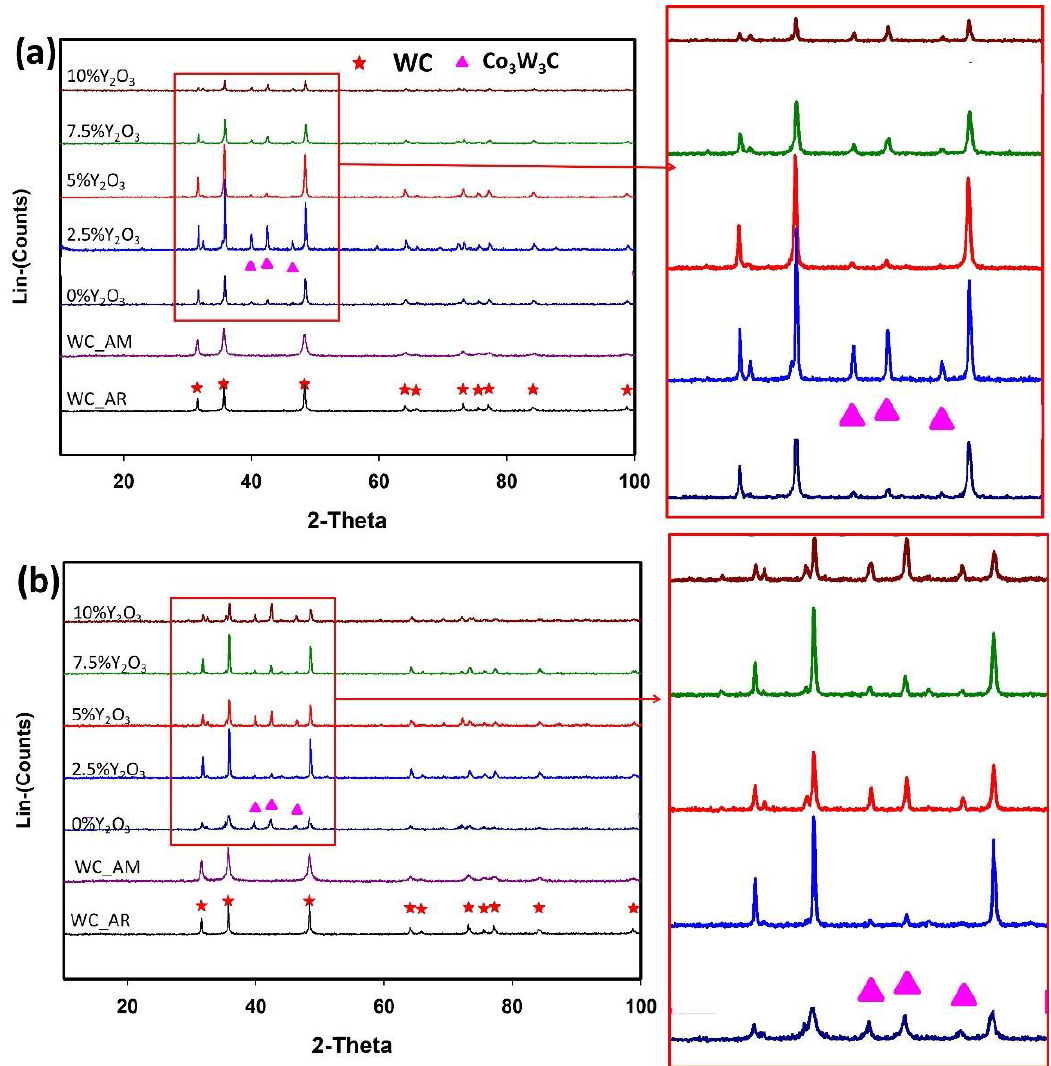
Figure 6. XRD patterns of the as-received (AR), as-milled (AM) powder after sintering of different composites. ( a ) WC-Co-TaC-NbC with different additions of Y 2 O 3 . ( b ) WC-Co-TaC-NbC with an addition of 5 wt% Ni and different additions of Y 2 O 3 . Enlarged areas for the indicated rectangles in each chart are illustrated to the right.